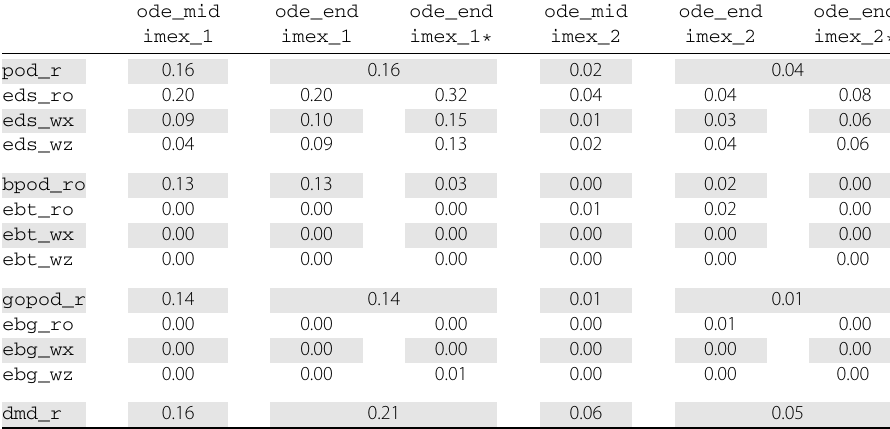
Table 6 MOR SCORE s μ (200, (cid:16) mach(16) ) in the L 2 ⊗ L 2 error norm for the “MORGEN” test network from Sect. 6.3; * notes linear